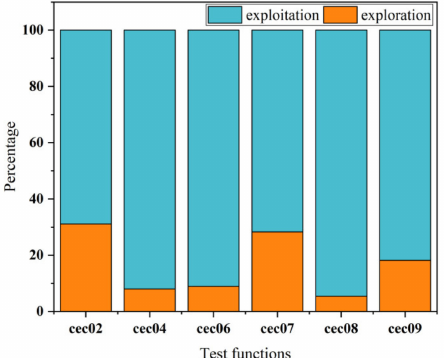
Figure 4. The percentage of different